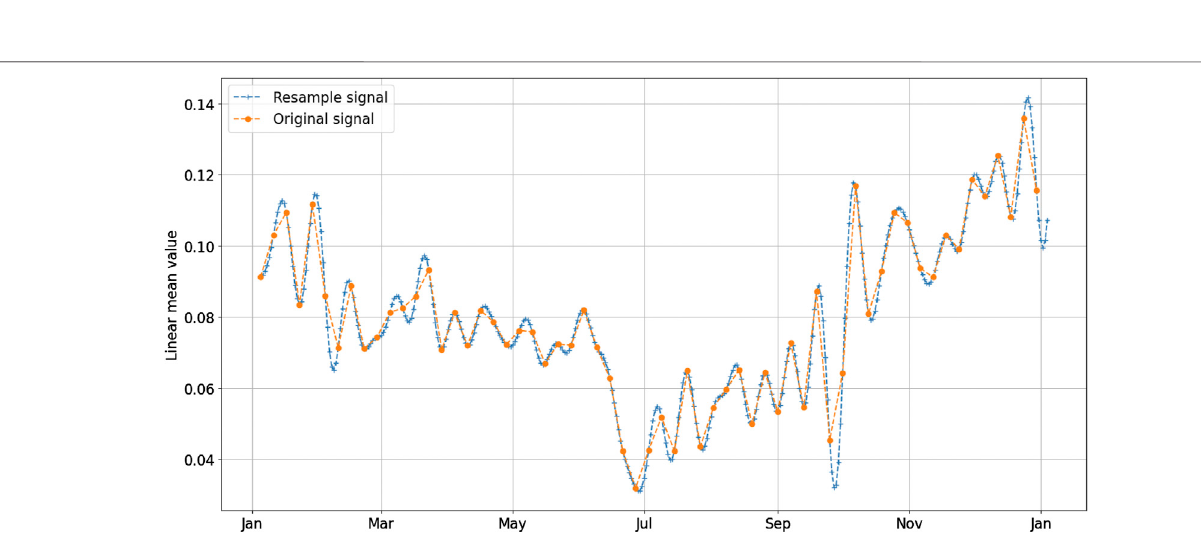
Frontiers in Remote Sensing |